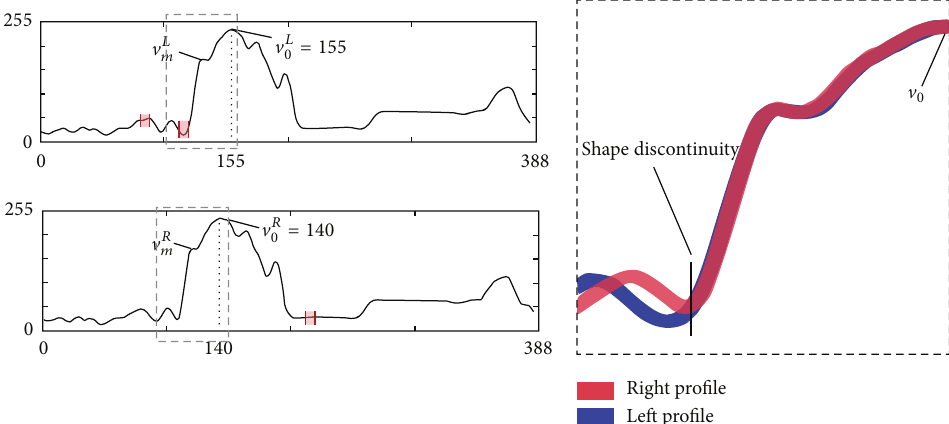
Figure 2: Enlargement of an actual section of the two intensity profiles from the Tsukuba images overlapped to emphasize the shape discontinuity and one of the missing highlighted sections of Figure